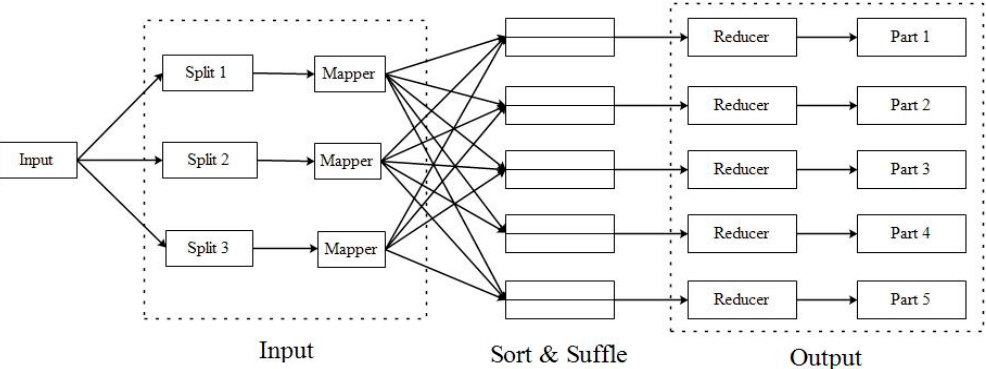
Figure 1. MapReduce programming architecture consisting of Input, Sort & Shuffle and Output stages.